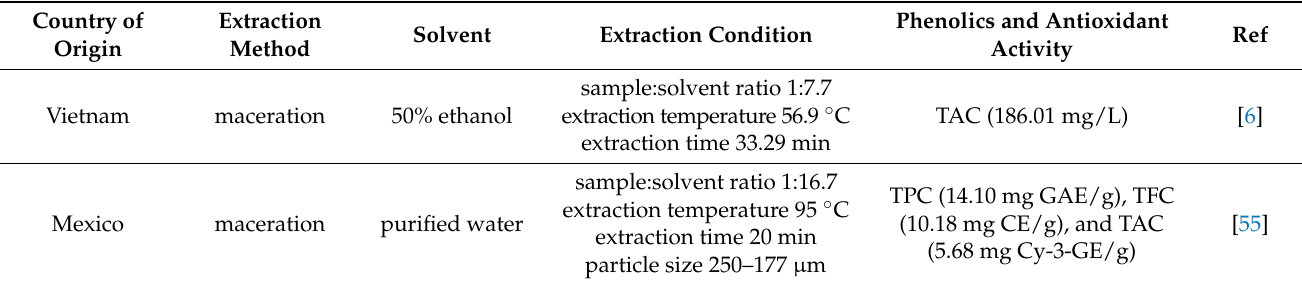
Table 1. The extraction methods used for roselle phenolic compounds and antioxidant activities. Abbreviations: TPC: total phenolic compound, TFC: total flavonoid compound, TAC: total anthocyanin compound, UAE: ultrasound-assisted extraction, MAE: microwave-assisted-extraction, SFE: supercritical fluid extraction, GAE: gallic acid equivalents, Cy-3- GE: cyanidin-3-glucoside equivalents, CE: catechin equivalents, QE: quercetin equivalents, ACEI: angiotensin-converting enzyme inhibitory, FRAP: ferric ion-reducing antioxidant power, ORAC: oxygen radical absorbance capacity,